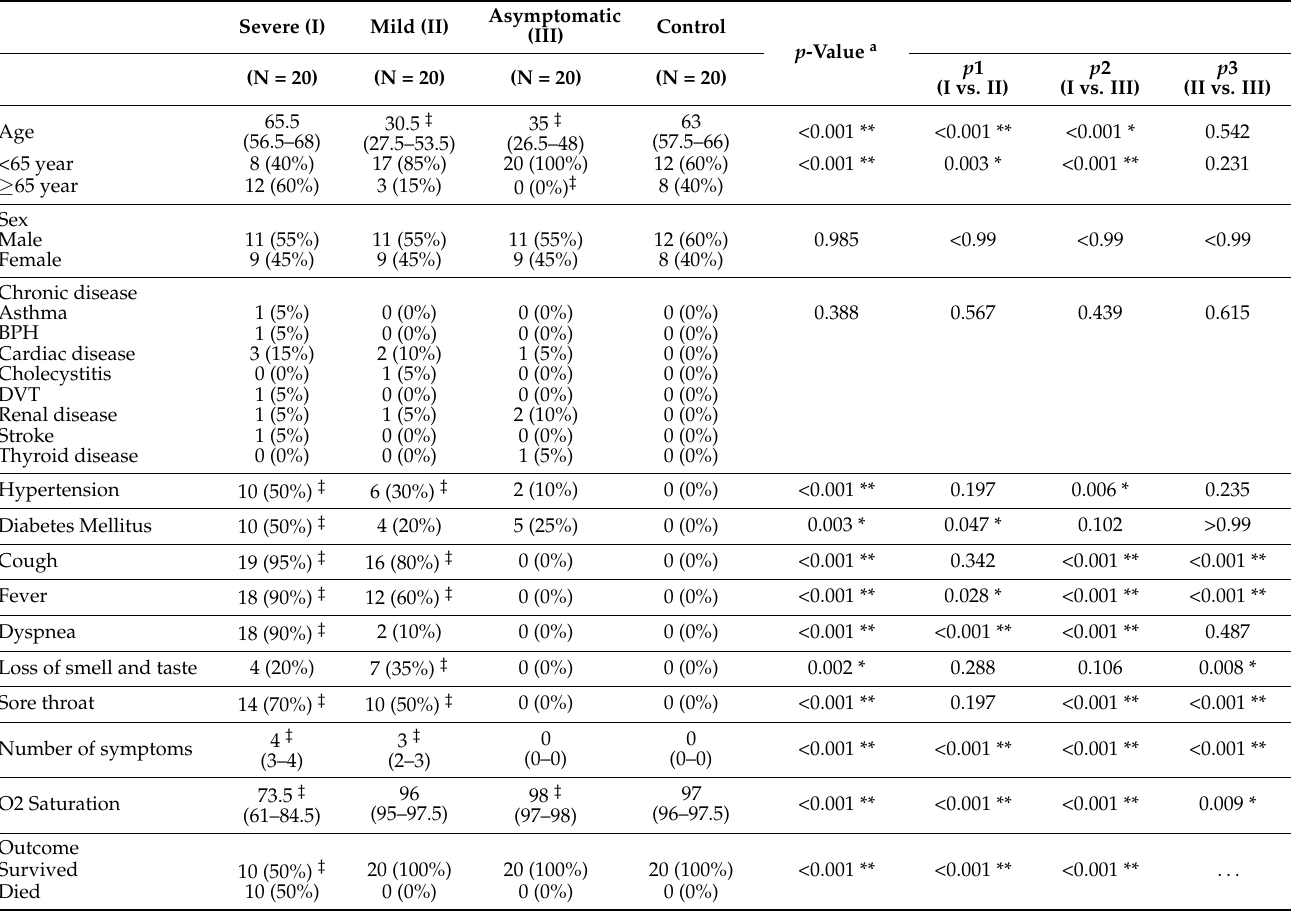
Table 1. Comparison of demographic and clinical criteria in the studied